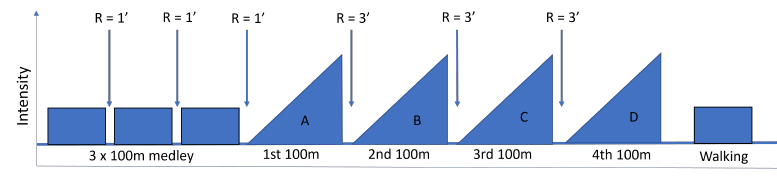
Figure 1. Overview of the protocol.